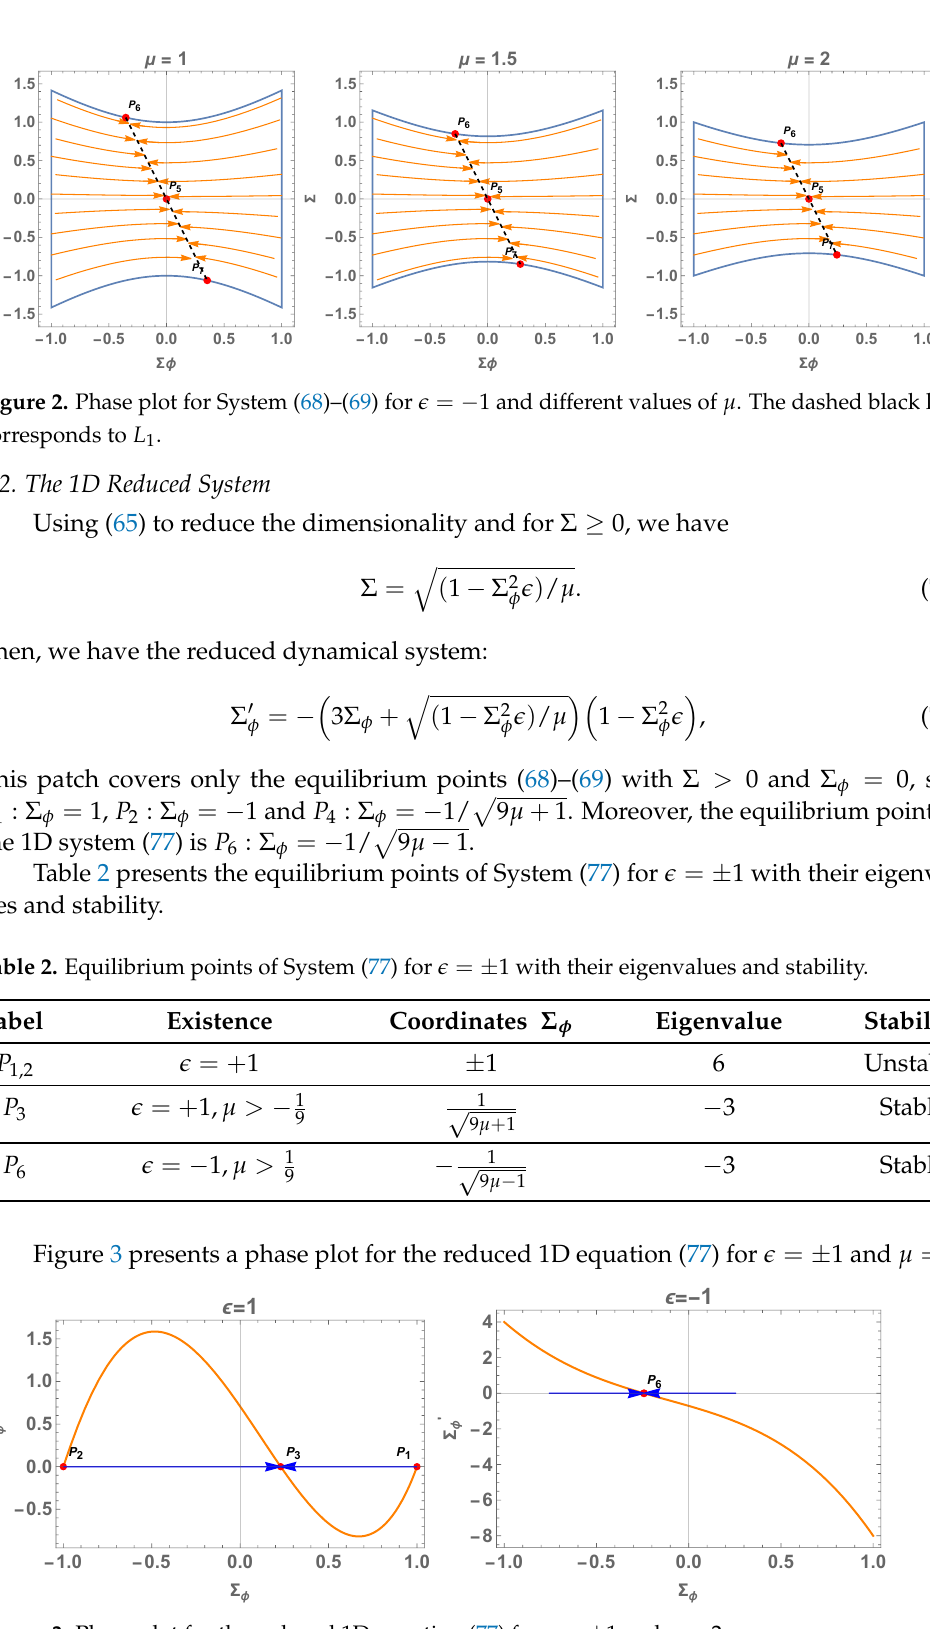
Figure 3. Phase plot for the reduced 1D equation (77) for (cid:101) = ± 1 and µ = 2. On the other hand,